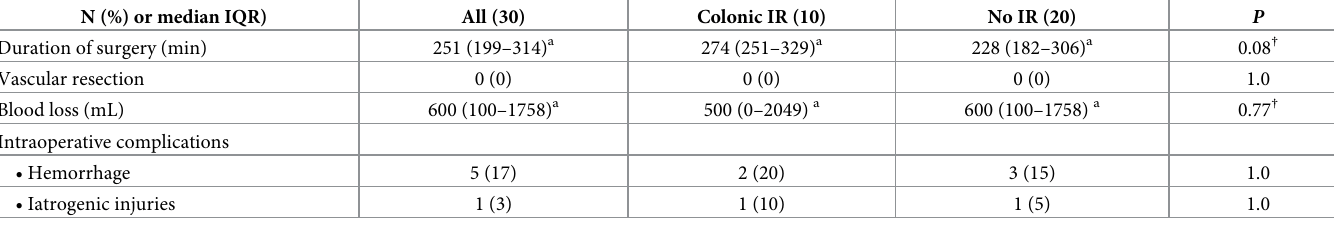
Table 6. Operative data of patients undergoing colorectal surgery with and without experimental in vivo colonic IR. N (%) or median